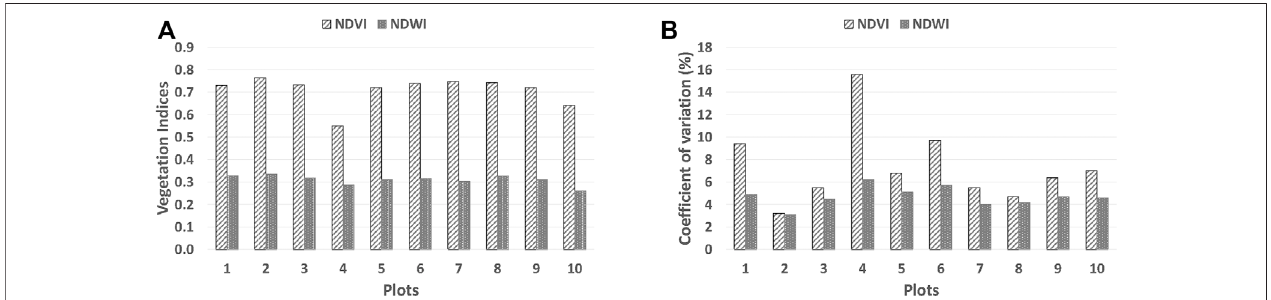
FIGURE5| Mapsof (A) NDVI, (B) GNDVI,and (C) NDRE,fortheselectedriceplotsinQuintadoCanal(July9,2020).TheUAS fi eldimageshaveaspatialresolution of 0.074 × 0.074 m 2 .